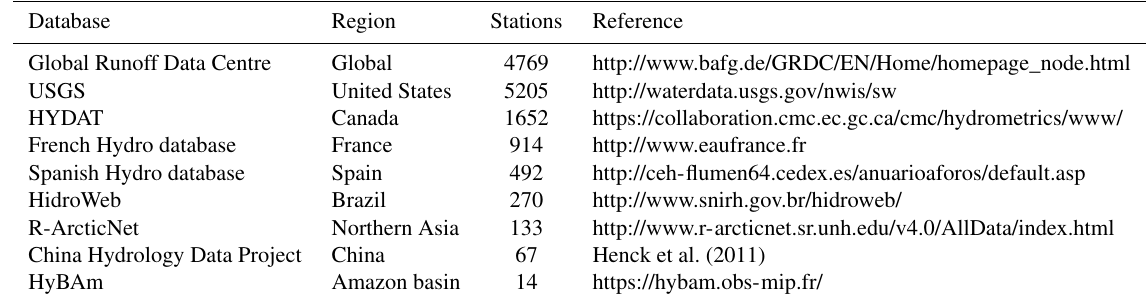
Table 2. Description of the databases considered for the selection of in situ gauge stations with at least 3 years of discharge observations within the period 1979–2014. All websites were last accessed on 25 February